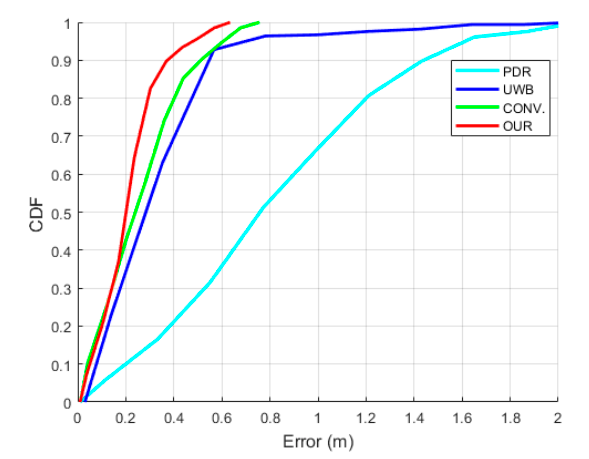
Figure 15. Position trajectory of each algorithm in multi-lap LOS+NLOS scenario.